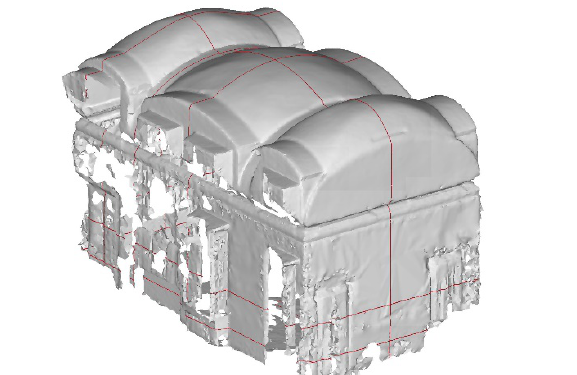
Figure 11. Solid model from 3DReshaper - ‘Prima Anticamera’ (Modelling: F. Natta)